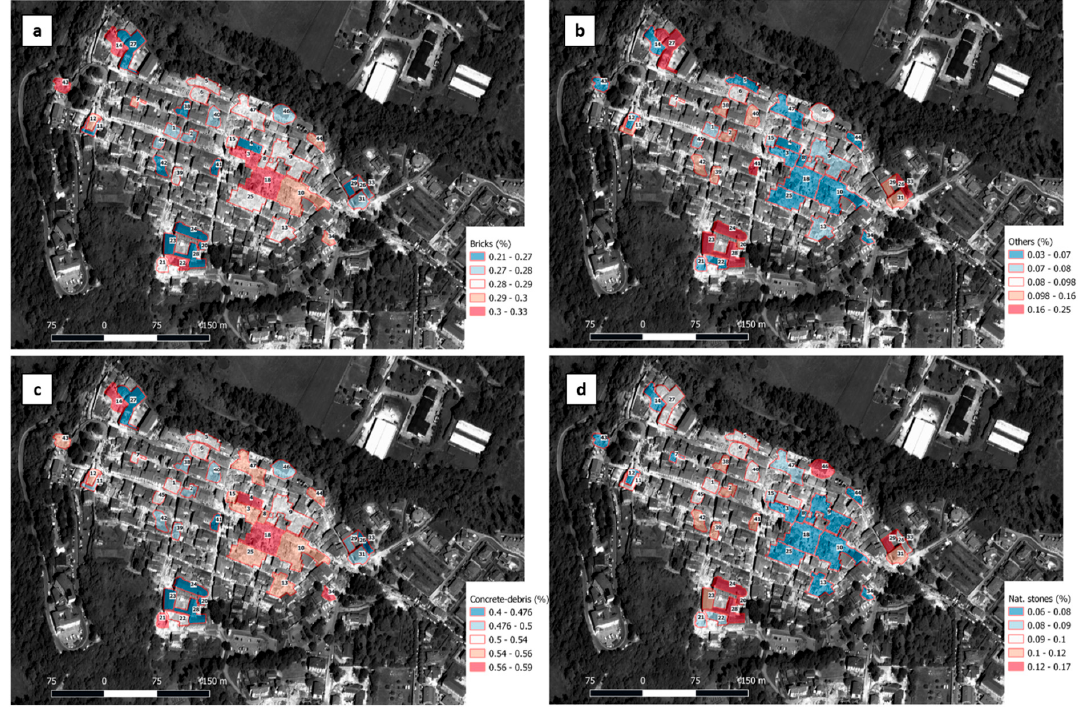
Figure 10. Estimated percentage distributions of the types of materials found within the rubble heaps in the centre of Amatrice town. The four maps refer respectively to: bricks ( a ), other building materials ( b ), concrete-debris ( c ) and natural stone ( d ). Table 7. Volumes and main constituents (for a sample of rubble heaps located in the most a ff ected area). For each heap the asbestos’ presence is also